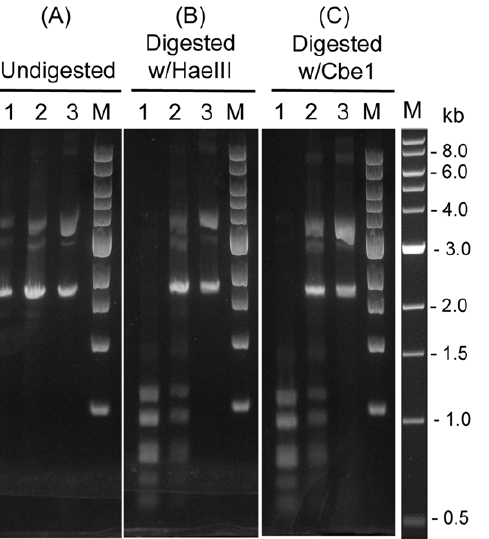
Figure 2. Protection of DNA by M.CbeI or M.HaeIII from digestion invitro . In each panel, lane 1 is unmethylated plasmid DNA (pUC18) isolated from E. coli ( dam + dcm + ), lane 2 is plasmid DNA methylated in vitro with M.HaeIII (NEB) at 37 u C, lane 3 is plasmid methylated with purified M.CbeI at 78 u C. (A) undigested. (B) digested with HaeIII (C) digested with purified CbeI. DNAs were subjected to